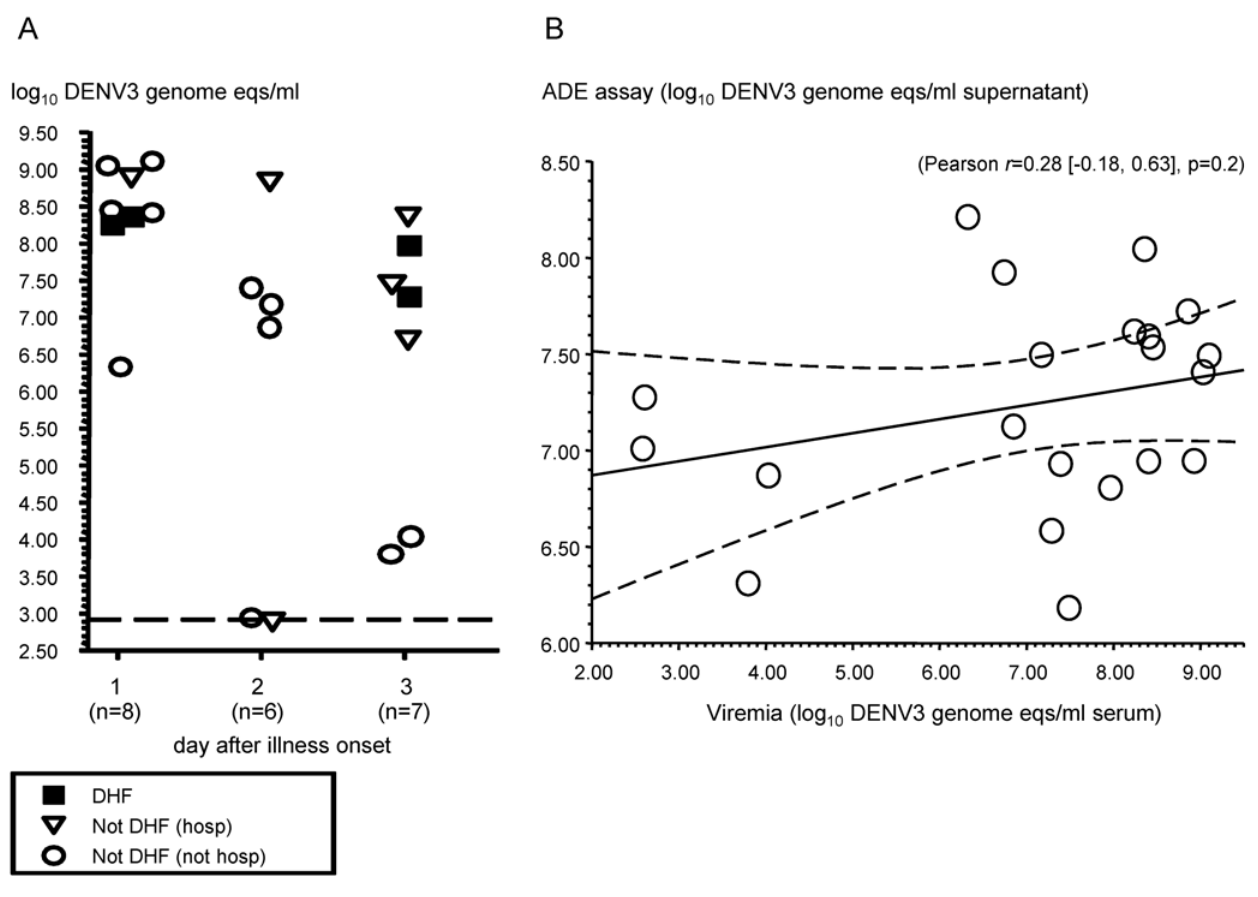
Figure 6. Early viremia levels and ADE activity at illness onset in infants with symptomatic primary DENV3 infections. (A) Early viremia levels in acute-phase sera from infants with symptomatic primary DENV3 infections. Values are log 10 transformed DENV3 genome eqs/ml measured in single acute-phase serum samples collected between 1–3 d after illness onset. Closed squares, hospitalized infants with DHF; open triangles, hospitalized infants without DHF; open circles, nonhospitalized infants without DHF. Line represents the lower limit of quantitation (2.93 log 10 DENV3 genome eqs/ml). (B) Mean log 10 transformed DENV3 genome eqs/ml from ADE assay cell culture supernatants versus viremia levels in single acute-phase serum samples collected between 1–3 d after illness onset ( n =21). Mean [95% CI] of the Pearson correlation coefficient ( r ) is shown. The linear regression curve and 95% CI are shown as a solid line and dashed lines, respectively.